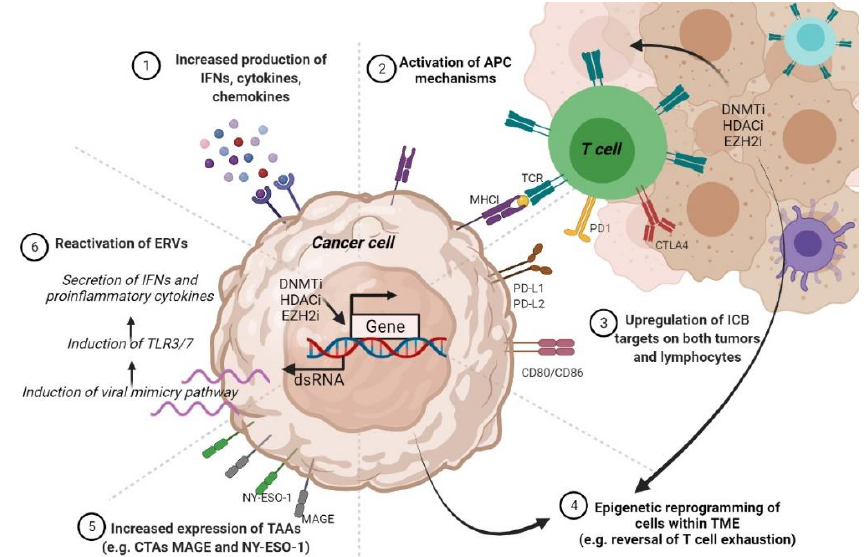
Figure 3. The proposed mechanisms by which epigenetic agents may regulate the immune